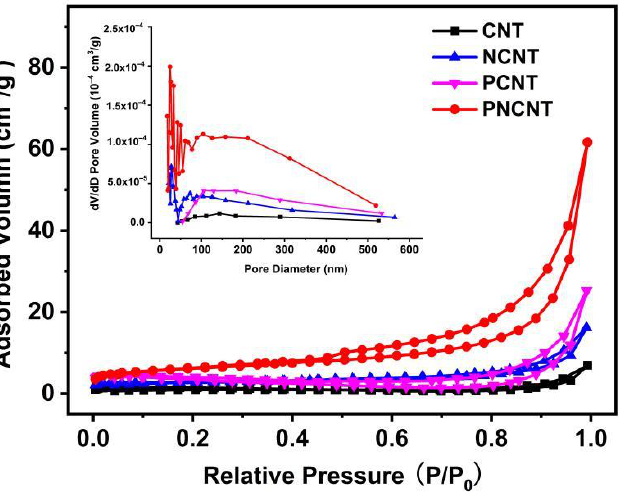
Figure 3. Nitrogen adsorption–desorption isotherms (inset shows the pore size distribution curves) of CNT, NCNT, PCNT and PNCNT samples.